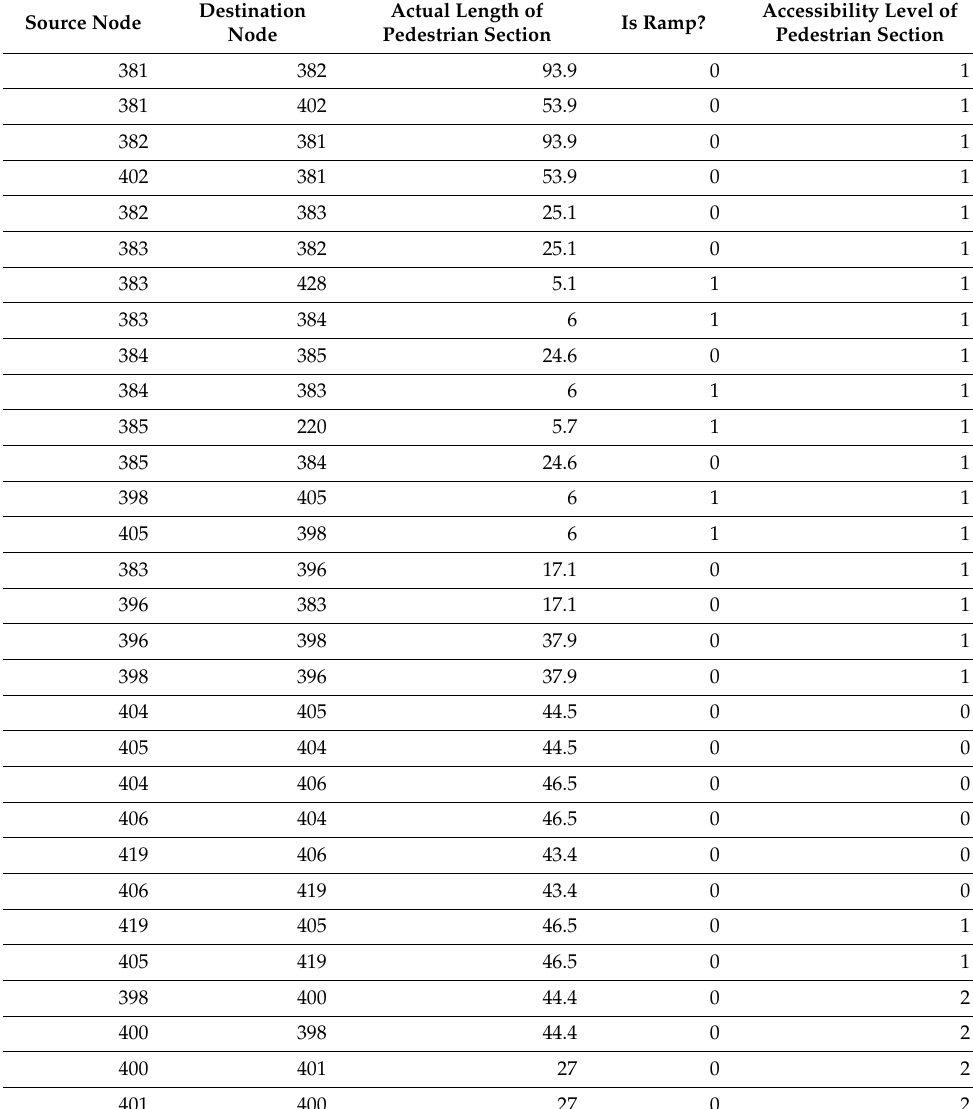
Table A3. Use Case